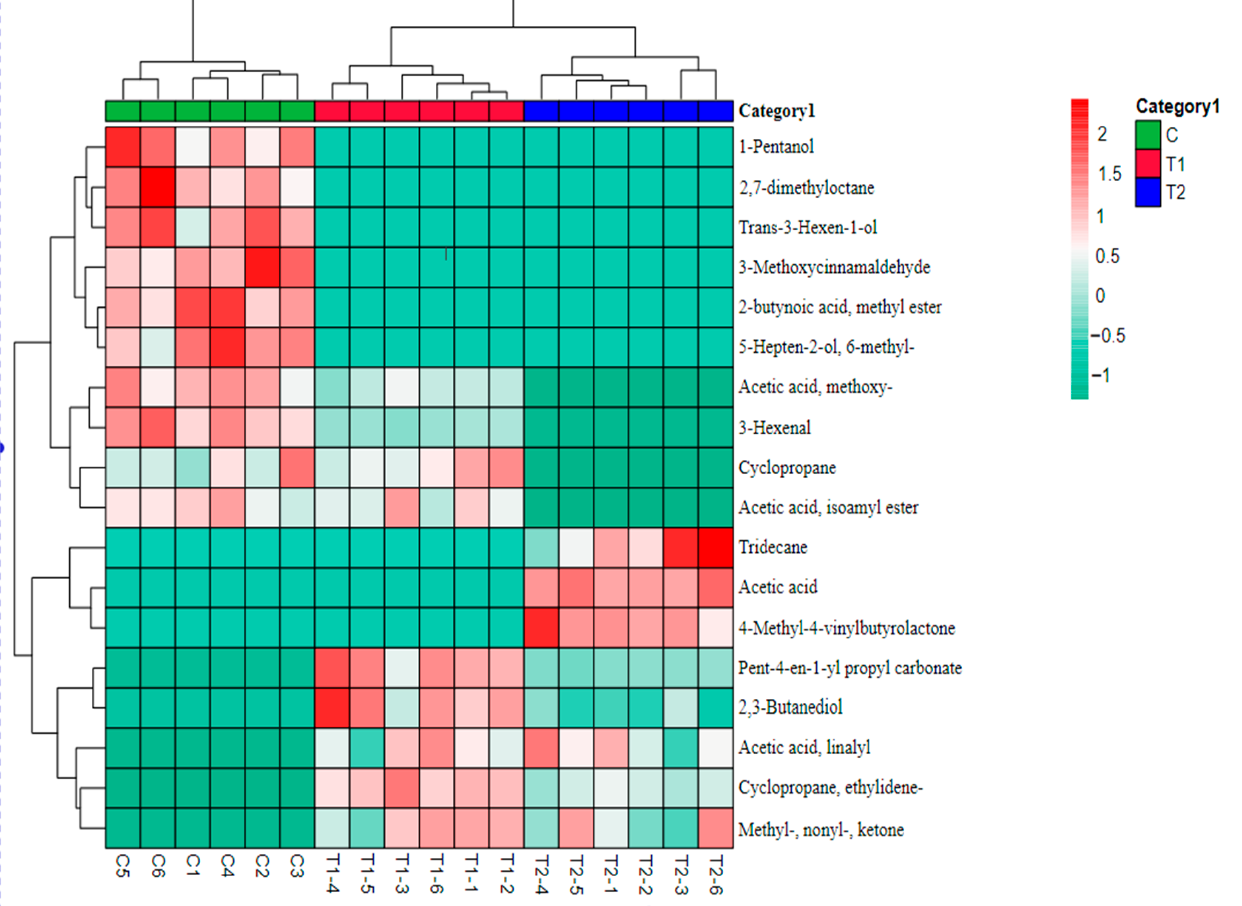
Figure 4. Spearman correlation analysis heatmap between different processing and the volatile components that have changed significantly in MPR. C: Control group; T1: test group 1 (using the improved technology of Sichuan spicy flavor formula); T2: test group 2 (using the improved technology of halogen flavor